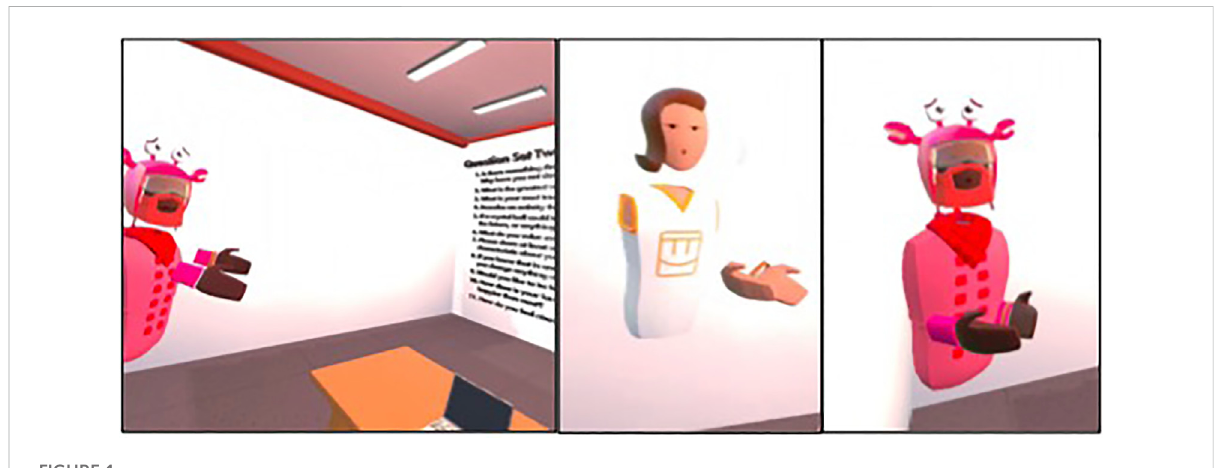
FIGURE 1 Virtual experimental room and participant Avatars.